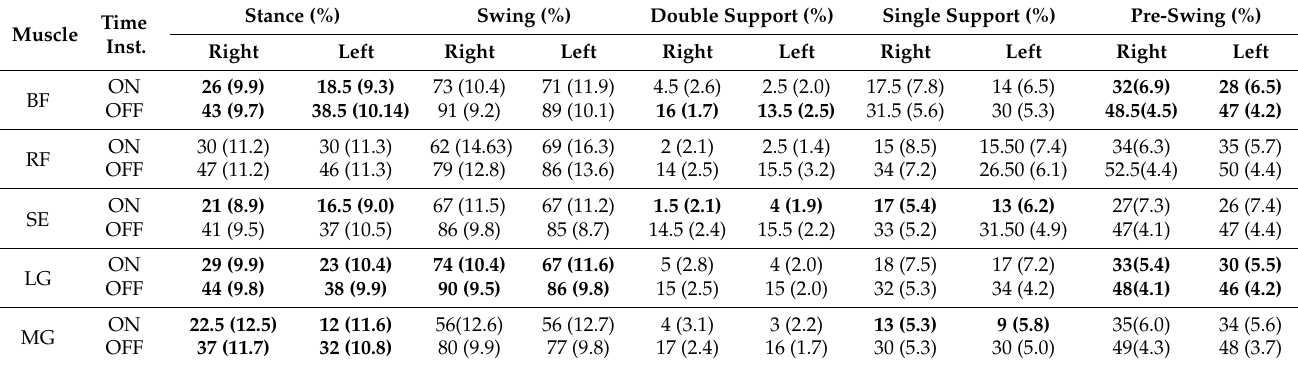
Values presented in median (MAD). Bold indicates a significant difference ( p < 0.05) between the right and left sides. Biceps femoris (BF), rectus femoris (RF), semitendinosus (SE), lateral gastrocnemius (LG), medial gastrocnemius (MG), right leg (R), left leg (L). ON stands for the onset and OFF—for the offset of muscular activation.